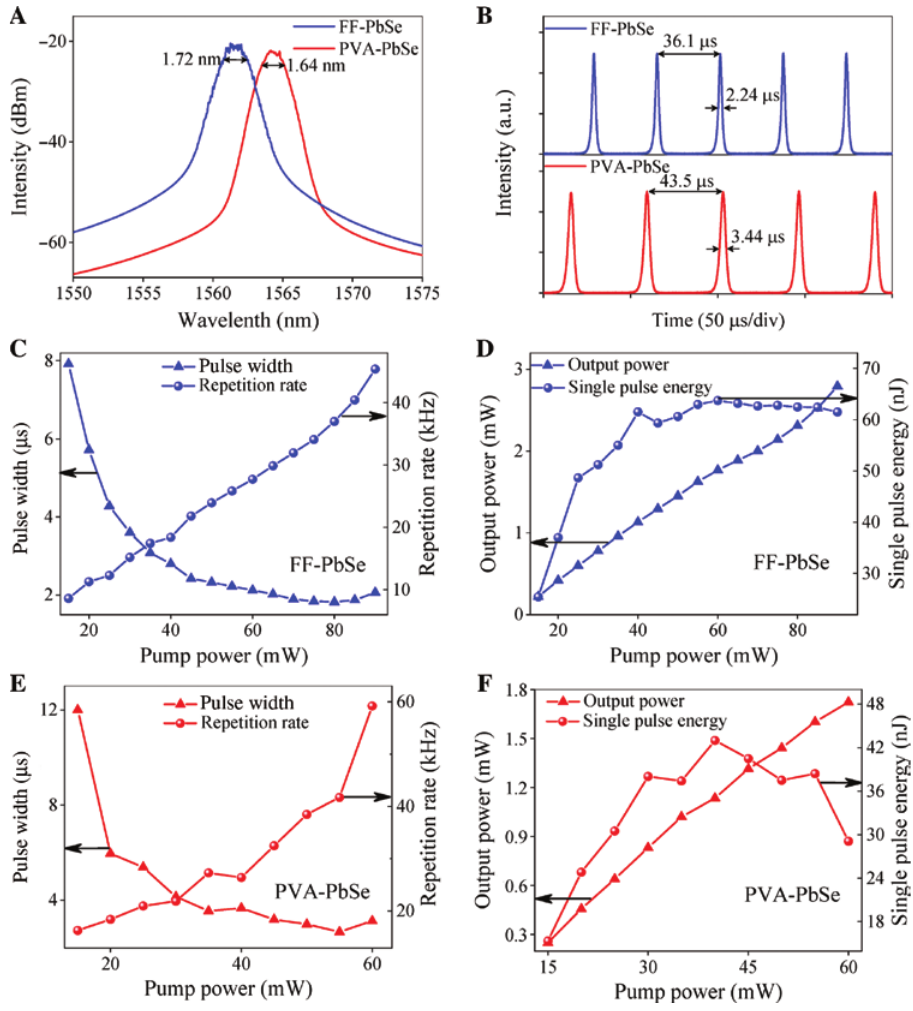
Figure 5: Performances of the FF-PbSe/PVA-PbSe Q-switched fiber laser. (A) Optical spectrum and (B) pulse trains of the Q-switched fiber laser based on FF-PbSe and PVA-PbSe SAs. (C) Pulse width and repetition rate, (D) output power and single pulse energy vs. pump power for FF-PbSe SA. (E) Pulse width and repetition rate, (F) output power and single pulse energy vs. pump power for PVA-PbSe